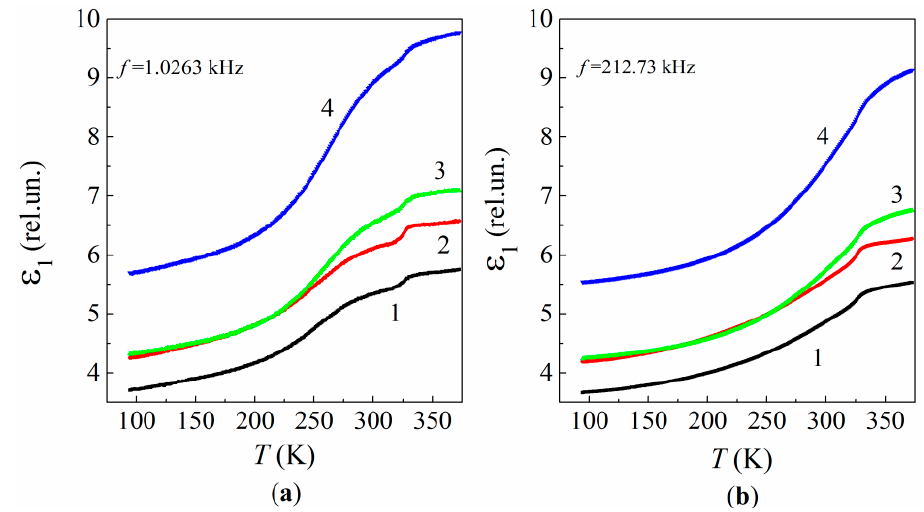
Figure 11. Temperature dependences of the relative dielectric permittivity for the neat epoxy (1) and MLG composites of 1% (2), 2% (3), and 5% (4) MLG at frequencies 1.0263 kHz ( a ) and 212.73 kHz ( b ).